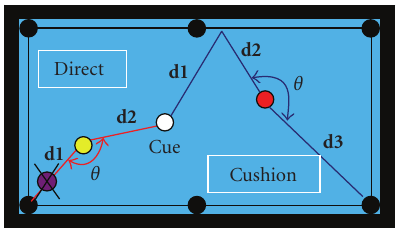
Figure 9: Evaluation of ball